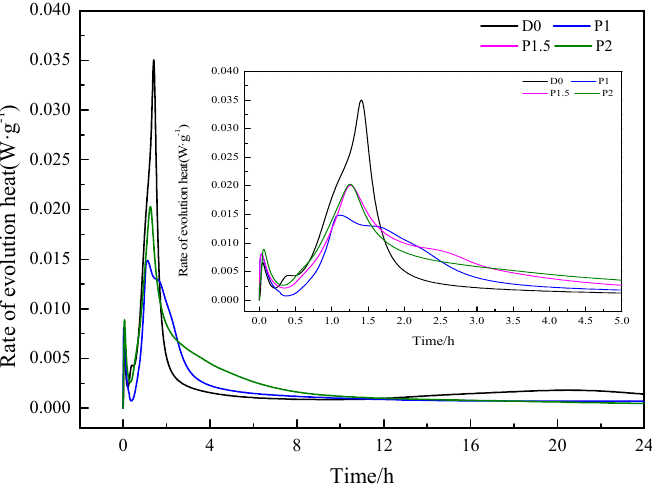
Figure 7. The rate of evolution heat of composite cement.